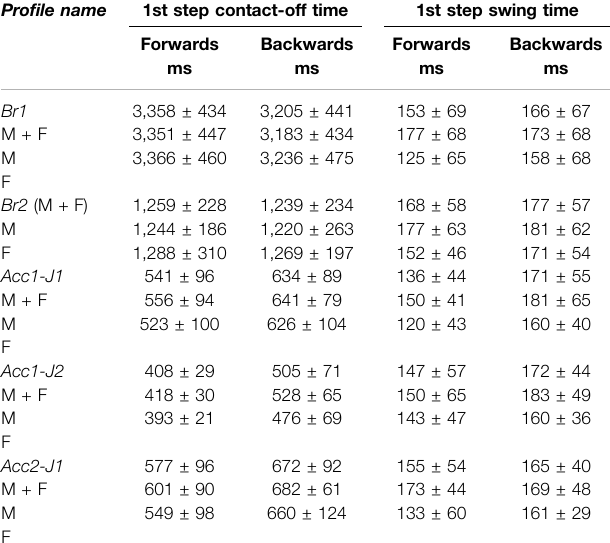
TABLE 4 | Average times for initiation (contact-off time) and duration (swing time) of the fi rst step, where observed (Males/Females, mean ±